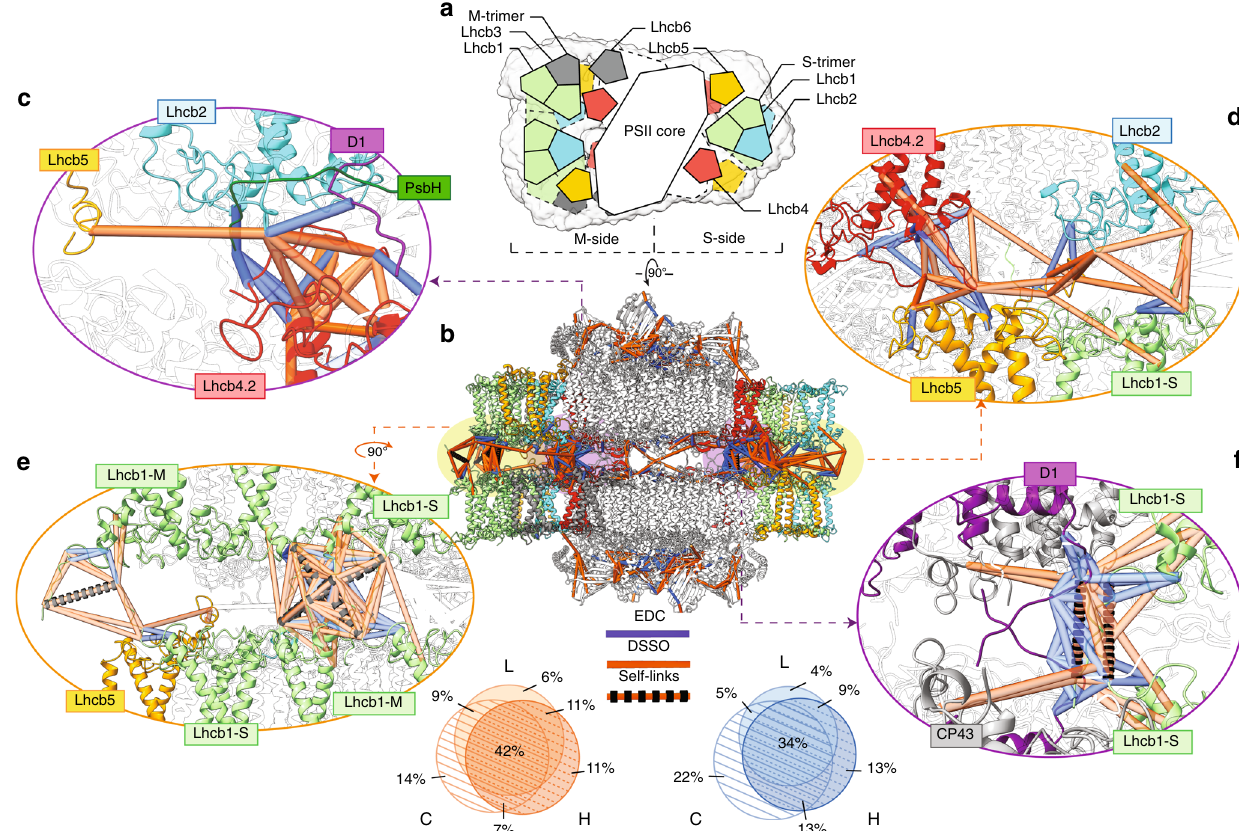
Fig. 3 Mapping of crosslinks in the paired PSII – LHCIIsc predicted structural model. a Schematic top-view of the (C 2 S 2 M)×2 fi tted in the cryo-EM map EMD-3825, showing the overall arrangement of the PSII – LHCIIsc subunits in the predicted models 1 – 3 (M-side and S-side are indicated). b Side-view with mapped crosslinks within the distance cut-off of 17 Å for EDC (blue lines) and 33 Å for DSSO (orange lines), and DSSO self-links (orange-black dashed lines). Venn diagrams showing the overlap between datasets of PSII – LHCIIsc L, C and H samples; only crosslinks present in at least two out of three samples were considered. The enlarged views highlight the crosslinks involving Lhcb2 ( c , d ) and Lhcb1 ( e , f ) at the periphery of the supercomplex ( d , e ) and close to the PSII core ( c , f ). Subunits are coloured as follows: Lhcb1 in light green; Lhcb2 in cyan; Lhcb4.2 in red; Lhcb5 in yellow; D1 in purple, PsbH in green and CP43 in grey. Subunits not involved in crosslinks are left